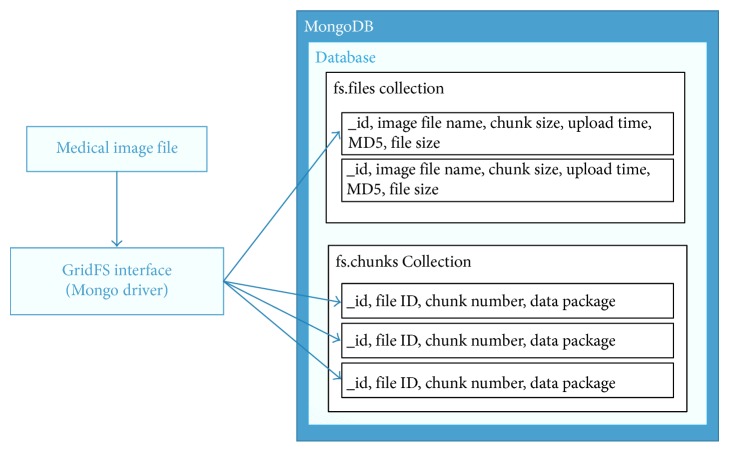
GridFS architecture.